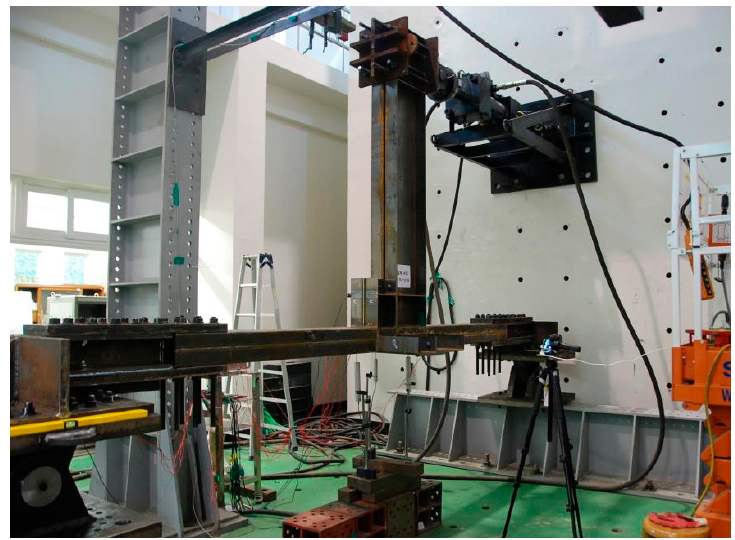
Figure 4. Test setup.